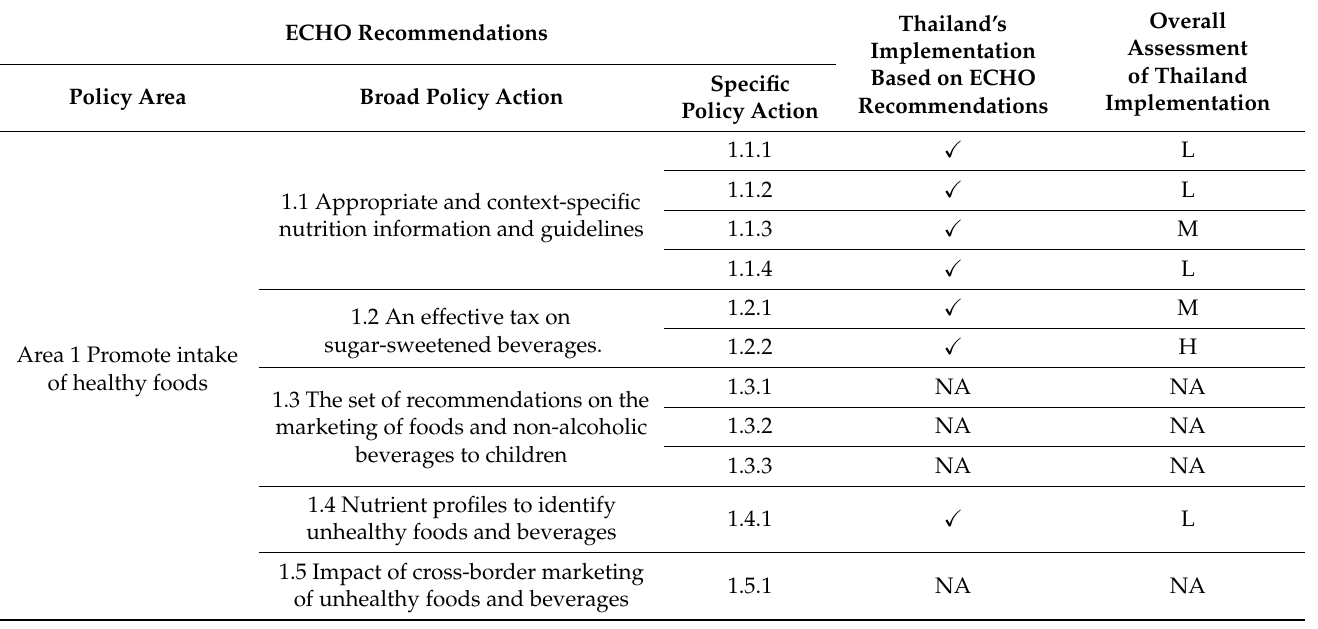
Table 2. Policy area, broad and specific policy actions of ECHO recommendations—their implementation in Thailand and their overall